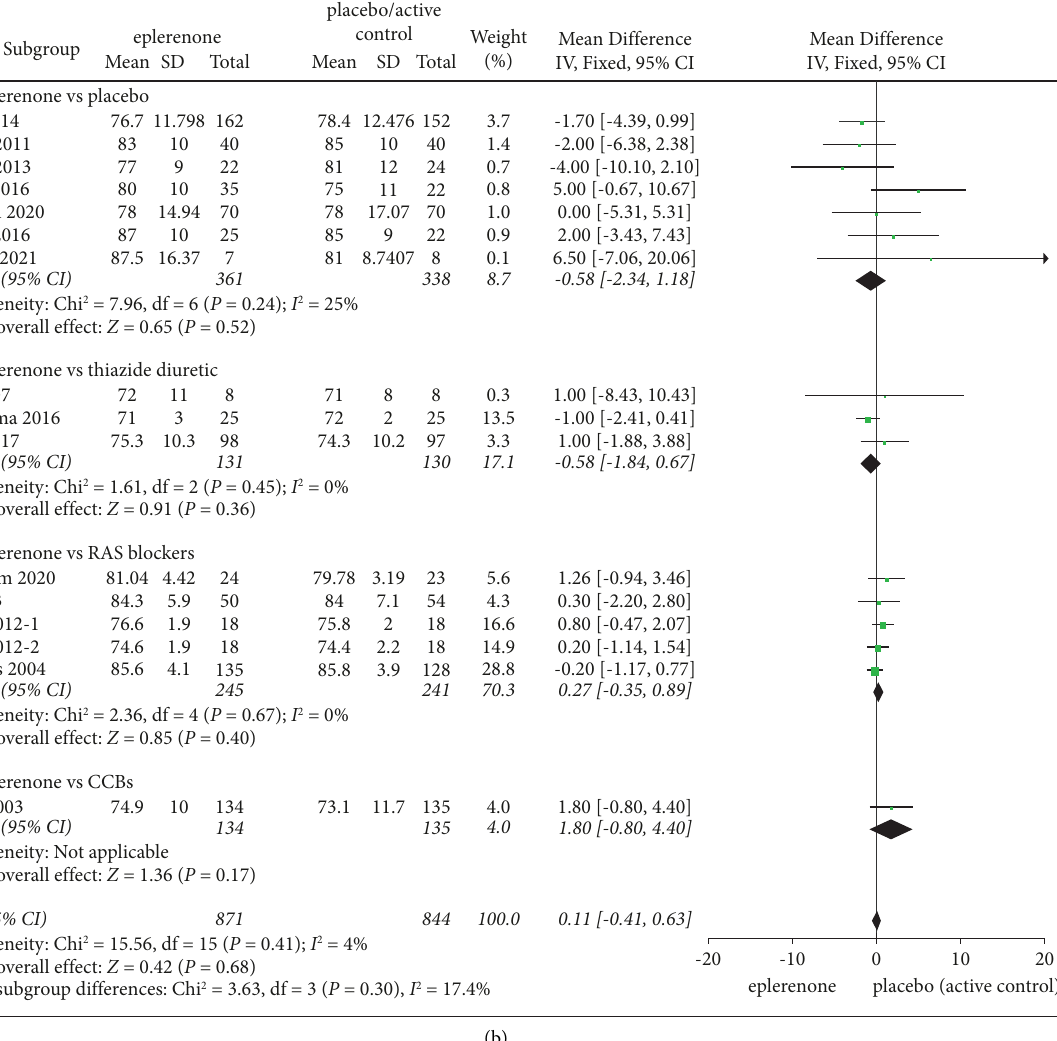
Figure 5: Forest plots of the efects on blood pressure between the eplerenone treatment groups and the control group. (a) Efect on SBP in articles comparing eplerenone to placebo/active control. (b) Efect on DBP in articles comparing eplerenone to placebo/active control. Te black diamond indicates summary information with the center of the estimate pooled with the median diference, and the width covers the relevant 95%